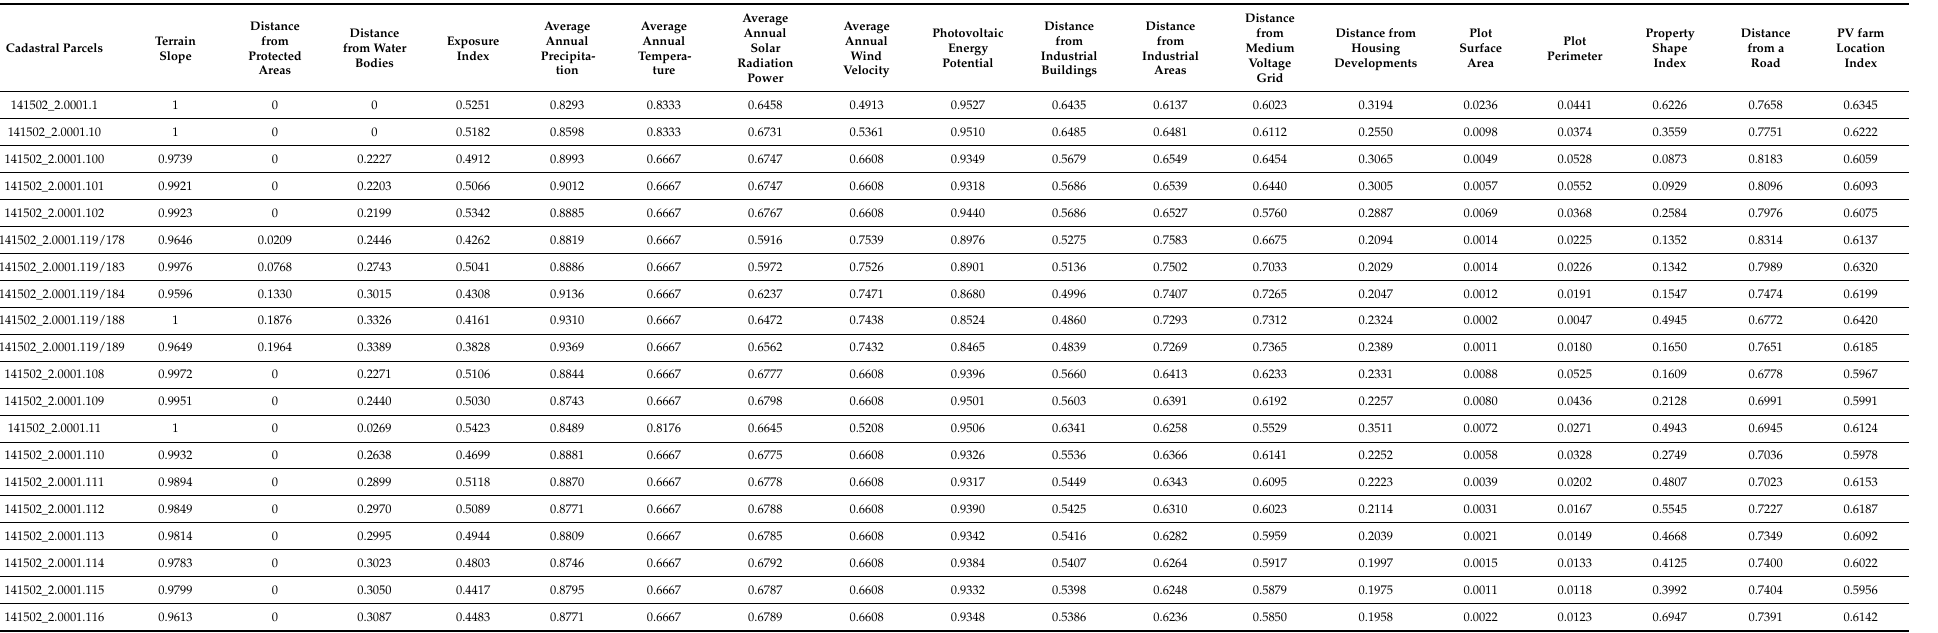
Table 4. A fragment of the capabilities matrix developed for the selected area (Czernia Commune). In total, this capabilities matrix contains 6990 objects of analysis.